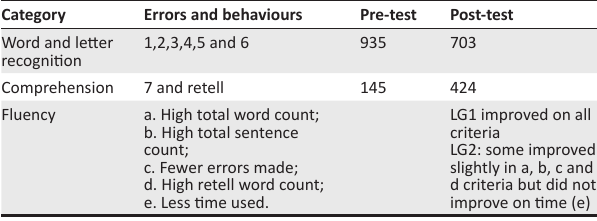
TABLE 3: Overall categories of reading behaviour.